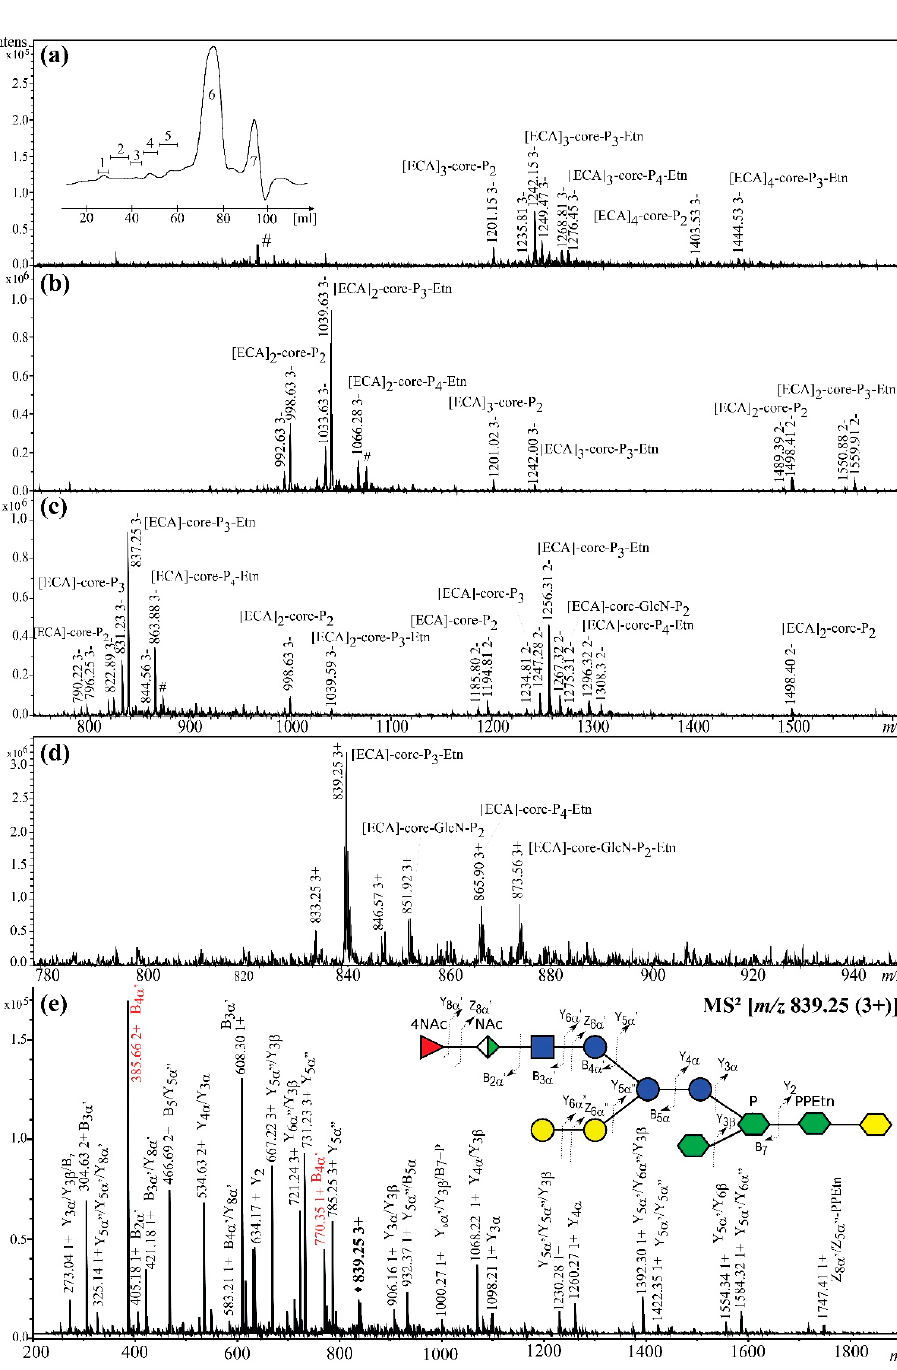
Figure 2. The electrospray ionization-ion trap (ESI) mass spectra of the [ECA] n -core OS identified in E. coli R1 LOS preparation obtained for ( a ) fraction 3 (negative-ion mode) with the Bio-Gel P-10 elution profile as the inset; ( b ) fraction 4 (negative-ion mode); ( c ) fraction 5 (negative-ion mode); ( d ) fraction 5 (positive-ion mode). ( e ) The positive-ion mode ESI-MS 2 spectrum of the ion at m/z 839.25 (3+) attributed to [ECA]-core-P 3 -Etn glycoform, where core stands for Glc 3 -Gal 2 -Hep 3 -Kdo oligosaccharide. The symbol nomenclature for glycans was used for carbohydrates visual representation: Fucose; Mannuronic acid; N-acetylglucosamine; Glucose; Galactose; L,D- manno -Heptose; Kdo; NAc, N-acetyl group [27]. The interpretation of ions is shown in Table 1. The most informative ions are colored in red. The mark # stands for non-interpreted ions.